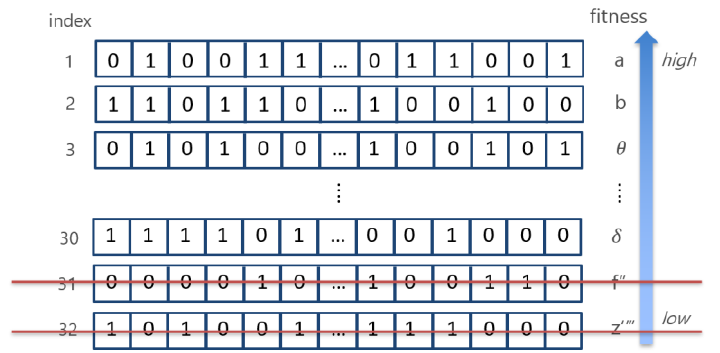
Figure 3. Elimination of two worst harmonies.